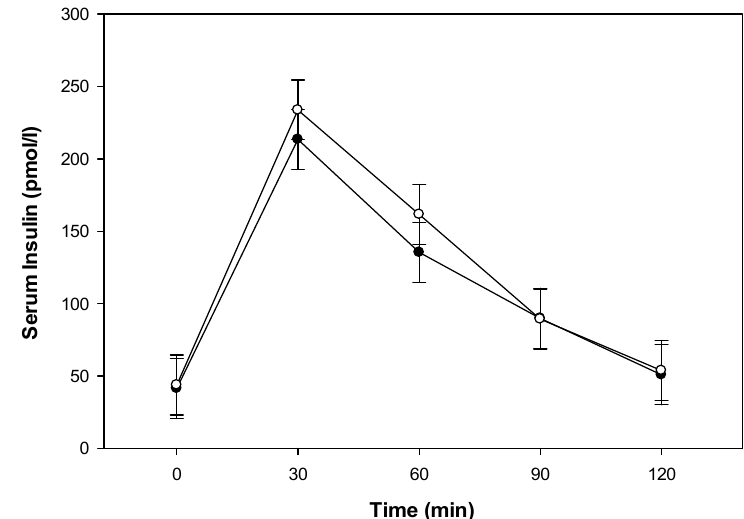
Figure 2. Plasma glucose and serum insulin concentrations after consumption of the blueberries ( ● ) or placebo gel ( ○ ) breakfast meals. Data are presented as arithmetic means ± SE, n = 17. All times points were significantly different from baseline, p < 0.05. For glucose and insulin there were no significant differences between responses from the blueberry or placebo breakfast meals.